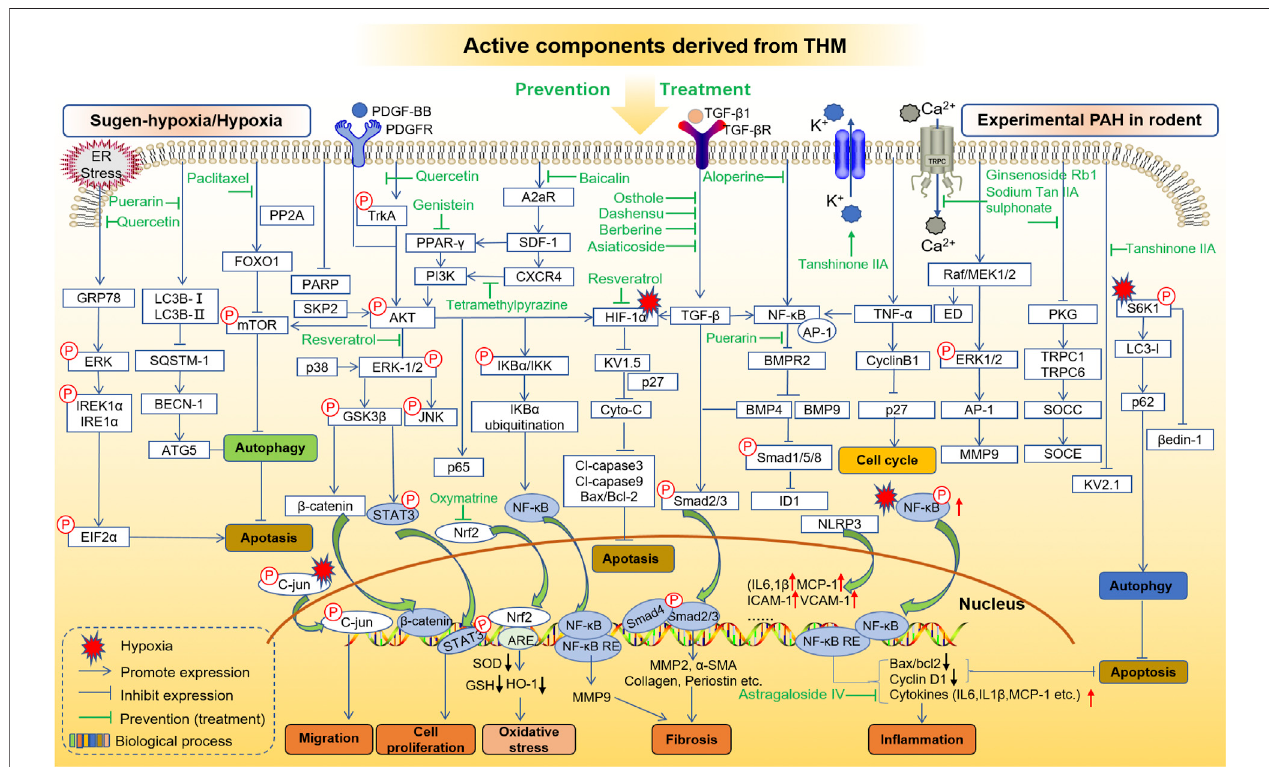
FIGURE 5 | Role and mechanisms of frequently studied active components derived from THM in treating sugen-hypoxia/hypoxia-induced PAH.